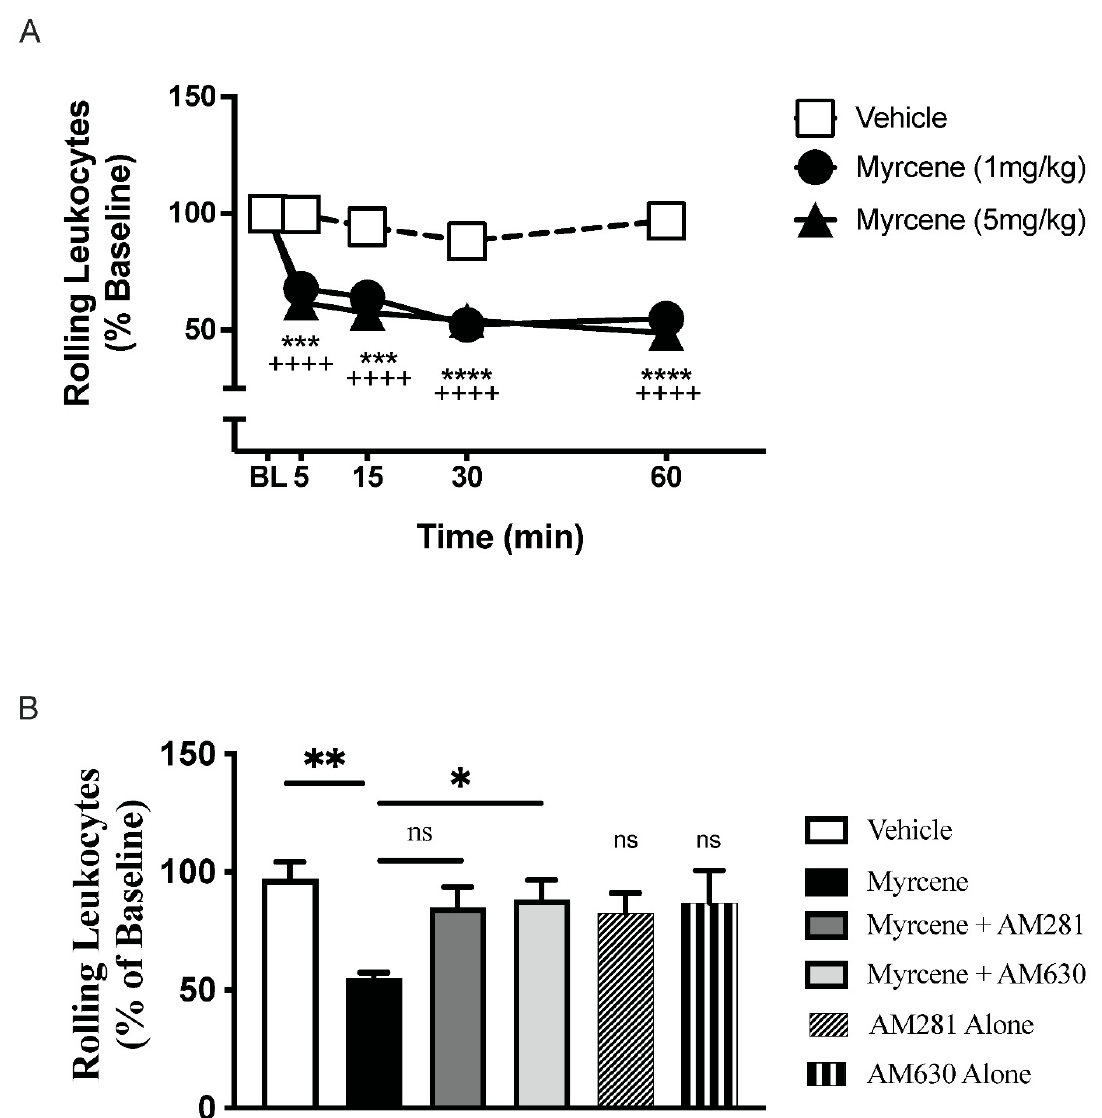
Figure 2. Acute myrcene treatment altered the kinetics of leukocytes in the arthritic joint microvas- culature. Topical administration of myrcene to day 7 adjuvant monoarthritic knees reduced the number of rolling leukocytes in post-capillary venules supplying the joint ( A ). The maximal response occurred at 60 min following the start of treatment. **** p < 0.0001, *** p < 0.001 (5 mg/kg dose) ++++ p < 0.0001 (1 mg/kg dose) two-factor RMANOVA with Bonferroni’s post hoc test.